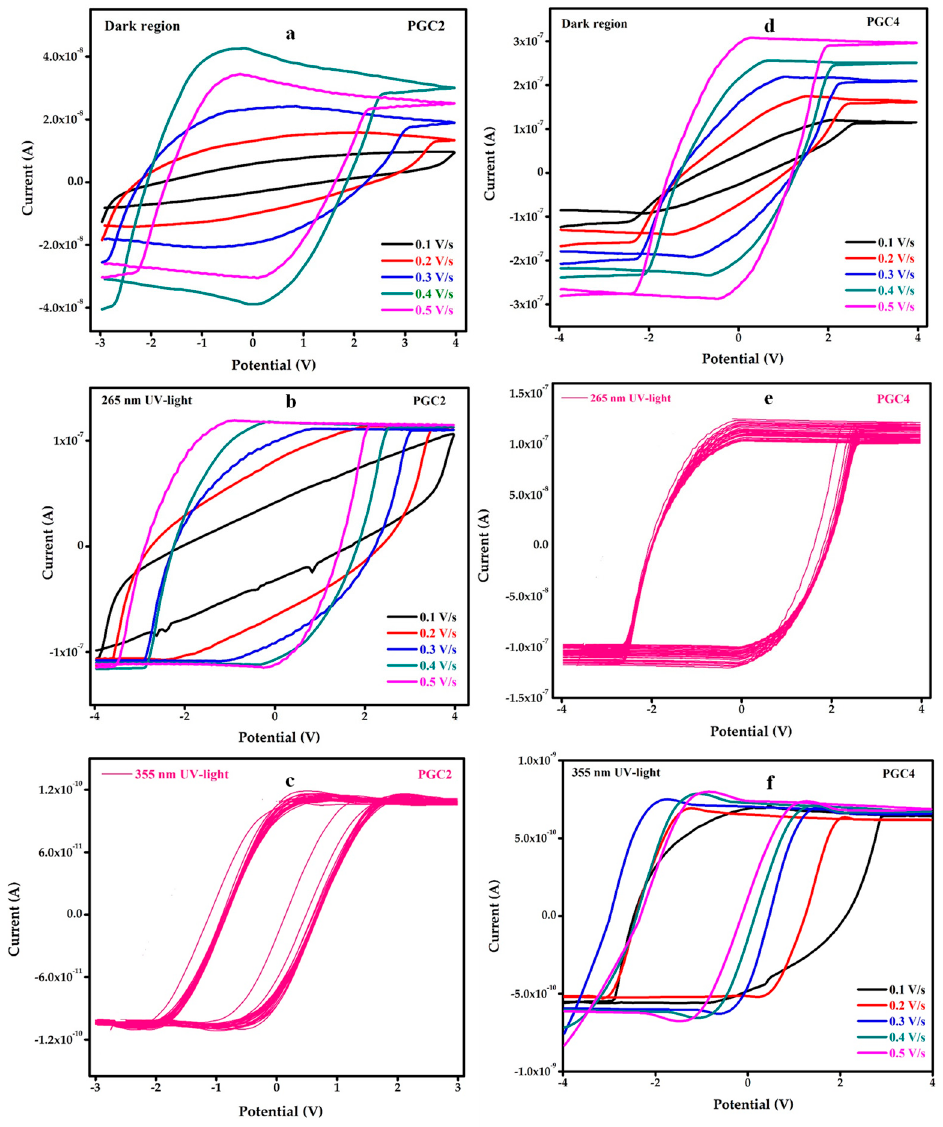
Figure 8. Typical CV curves of the PGC2 composite devices measured in the ( a ) dark region, ( b ) under 265 nm UV light, and ( c ) under 355 nm UV light. CV curves of PGC4 composite de- vices measured in the ( d ) dark region, ( e ) 265 nm UV light, and ( f ) under 355 nm UV